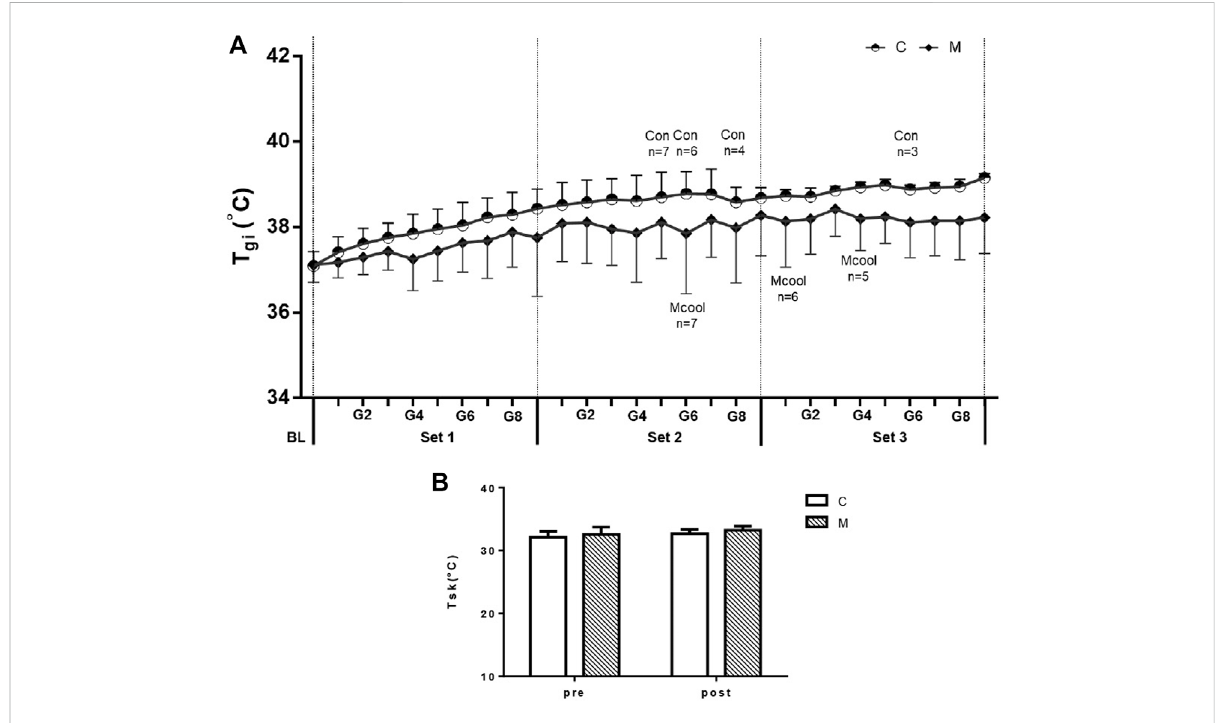
FIGURE 3 MeanT gi values (A) andmeanT sk values (B) inthesimulated tennismatchbetweenCONandMCOOLconditions.Verticallinesin (A) denotethe end of each “ set ” . (A) indicates the remaining participants ( n ) out of eight for each trial. All values are presented as Mean ± SD. M, mixed-cooling condition; C, control